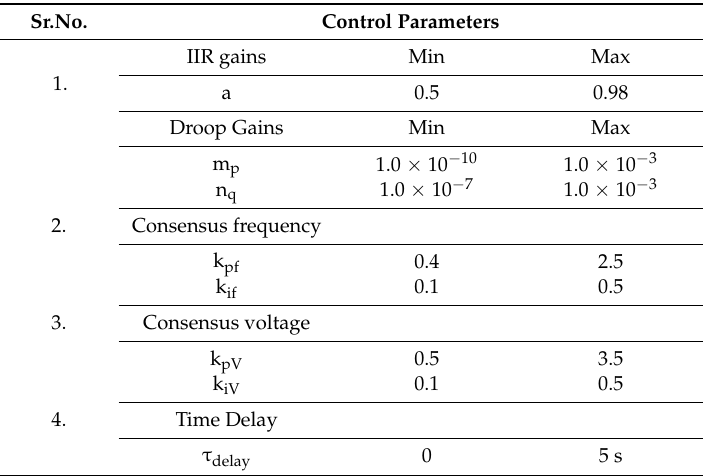
Table 3. Variation Range for Controller Parameters.